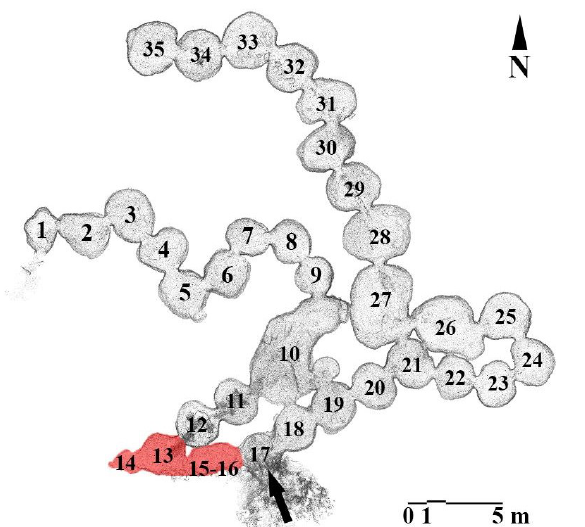
Figure 5 . BLK2GO point cloud. In red the rooms not previously surveyed.